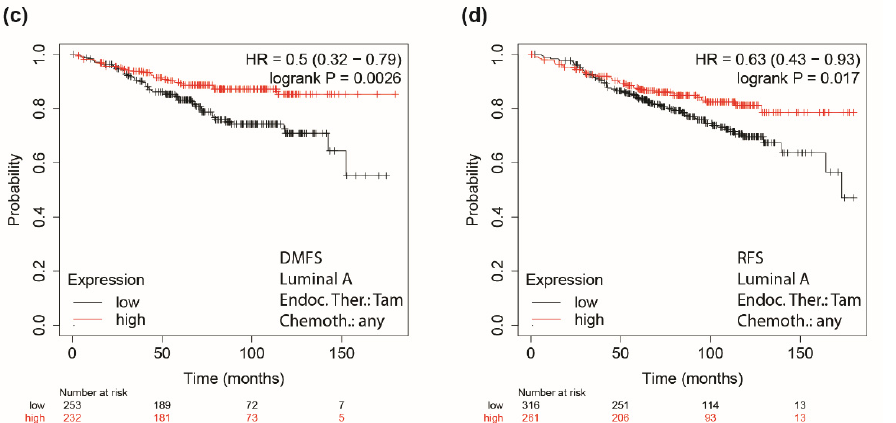
Figure 5. Role of integrin α 5 in FoxO3a-dependent inhibition of TamR cells migration and invasion and clinical implications. TamR cells were silenced for integrin α 5 as described in Section 2. The day after, cells were transiently transfected with F3aAAA for 24 h. pcDNA3.1 was used as a control vector. Cells were then employed for migration ( a ) or invasion ( b ) assays and counted using ImageJ software. The graphs report the % of migrating and invading cells. WB analysis was conducted on a duplicate set of cells to assess the effective depletion of integrin α 5 and overexpression of FoxO3a. β -Actin was used as a loading control. Results represent the mean ± s.d. of at least three independent experiments (* p ≤ 0.05, ** p ≤ 0.01, *** p ≤ 0.001). Kaplan–Meier curve for ( c ) DMFS (485 patients) and ( d ) RFS (577 patients) were evaluated in a cohort of luminal A subtype BC patients treated with tamoxifen and co-expressing both FoxO3a and integrin a5 transcripts.